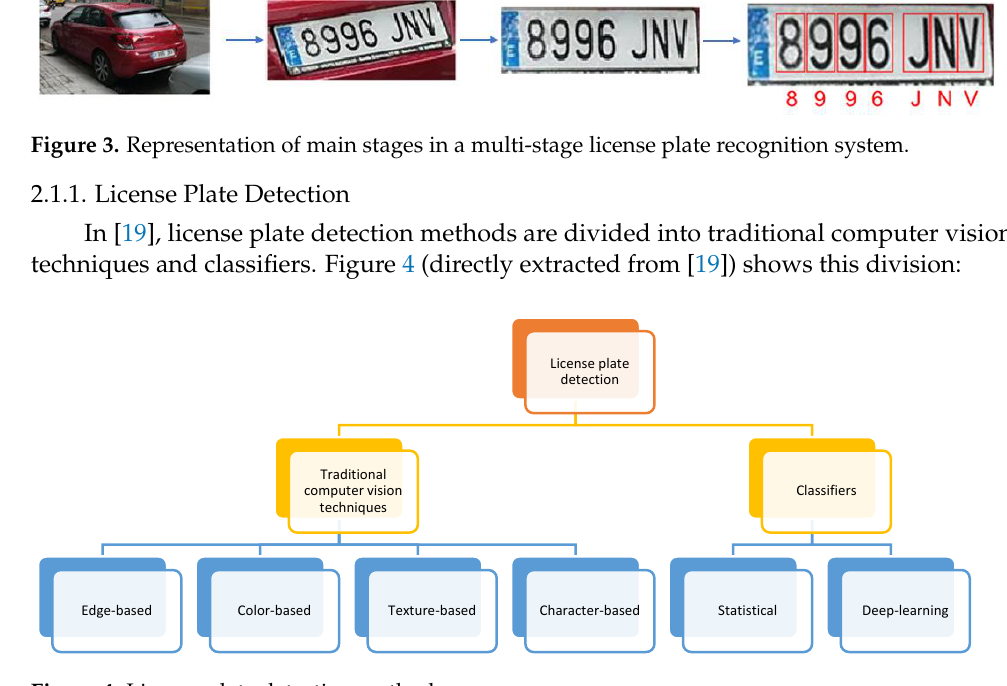
Figure 4. License plate detection methods.